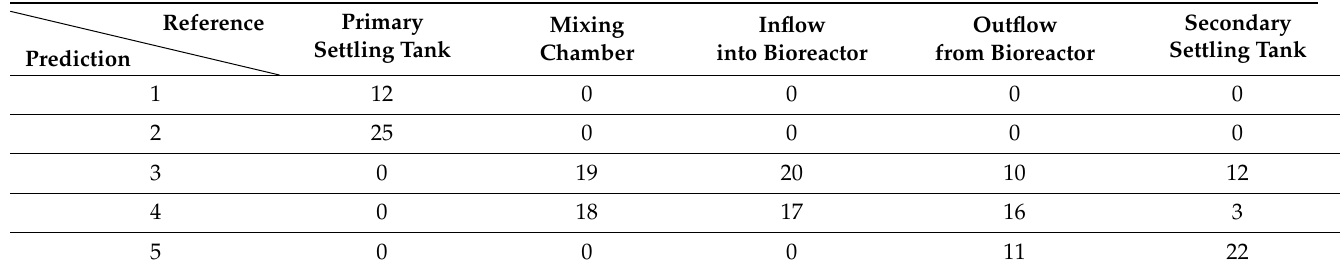
Figure 4. The result of the k-median clustering algorithm. The different shades indicate the clusters into which the observations were classified, while shapes indicate the corresponding stages in the wastewater treatment. The components listed on the graph axes are those created using the t-SNE method. Table 2. Number of correct classifications of observations into clusters formed by the k-median method, relative to reference values in the original